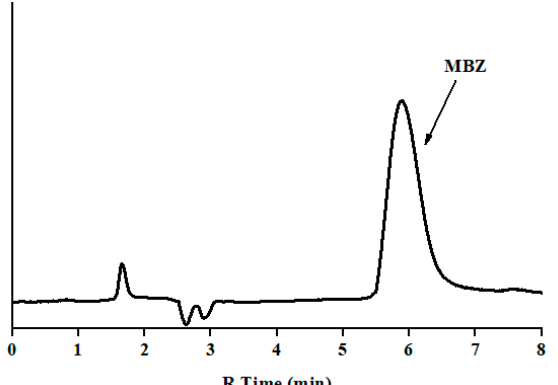
Figure 2. Chromatogram of standard mebendazole: mobile phase 0.15 M sodium dodecyl sulfate (SDS), 6% 1-pentanol ( v / v ) at pH 7; flow rate 1.0 mL / min; injection volume 20 µ L; and detection at 292 nm (y-axis is the absorbance in arbitrary units, and the same scale applies for Figures 2–4).